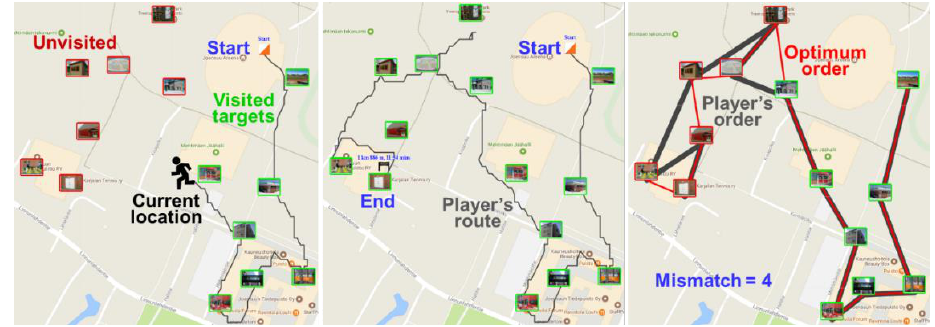
Figure 2. Examples of O – Mopsi playing (left), the final tour (middle) and comparison to optimum tour (right).